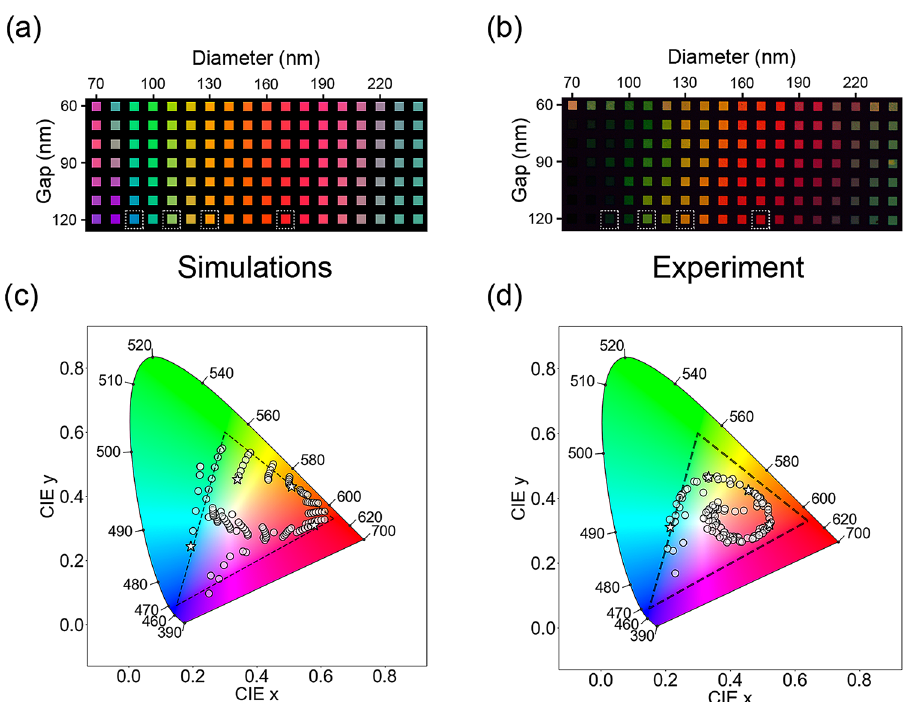
Figure 2. Numerical simulation ( a ) and experimental microscope imaging ( b ) results of the color palettes. CIE 1931 color diagram of numerical simulations ( c ) and experimental results ( d ). All the colors from the palette are marked as semitransparent circles; dashed triangle is the sRGB space. Dashed frames in ( a ) and ( b ) mark the colors for “N”, “S”, “L”, “M” letters corresponding to star markers in ( c ) and ( d